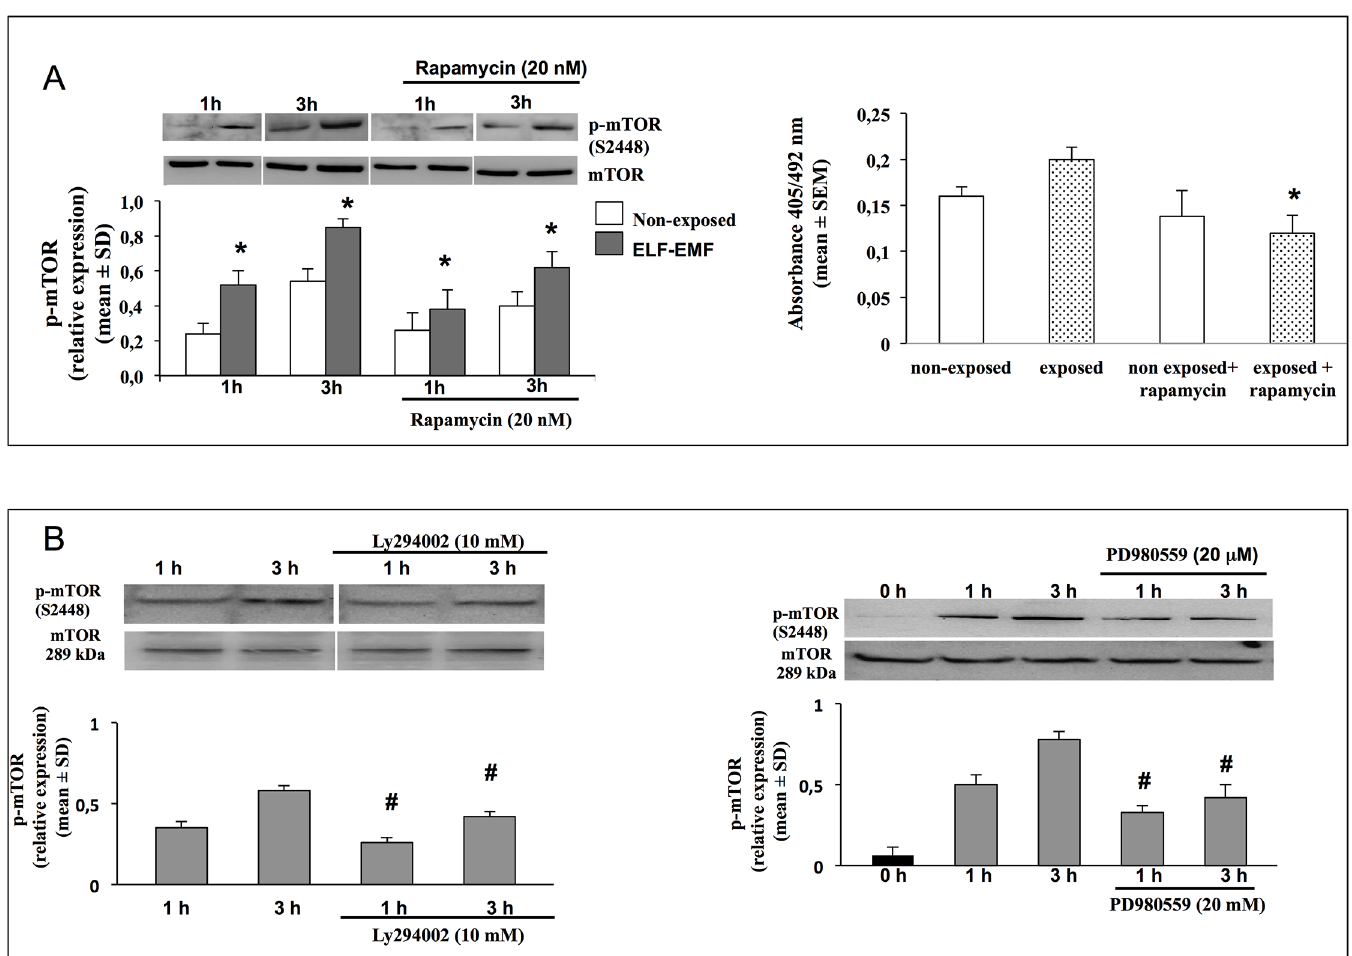
Fig 6. Effects of pharmacological inhibitors on mTOR activation. A. Representative image of immunoblotting for p-mTOR in HaCaT cell non-exposed or exposed for 1 and 3 h to ELF-EMF and treated or not with 20 nM Rapamycin. Data are reported as relative expression of p-mTOR vs un-phosphorilated form (mean ± SD, n = 3). * p < 0 . 05 treated cells vs cells no-treated with Rapamycin (lef). Proliferative rate of HaCaT cells assed by BrdU incorporation assay, after 24 h of incubation in non-exposed and exposed to ELF-EMF only for the first hour, and treated or not with 20 nM Rapamycin. Each bar represents the mean ± SEM of three independent experiments performed in triplicate. * p < 0 . 05 treated cells vs cells no-treated with Rapamycin (right). B. Representative image of immunoblotting for p-mTOR in HaCaT cell non-exposed or exposed for 1 and 3 h to ELF-EMF and pre-treated or not with selective inhibitor of PI3K (Ly294002, 1 μ M) and selective inhibitor of ERK kinase activity (PD980559, 1 μ M). Data are reported as relative expression of p-mTOR vs un-phosphorilated form (mean ± SD, n = 6). # p < 0 . 05 treated cells vs cells no-treated with selective